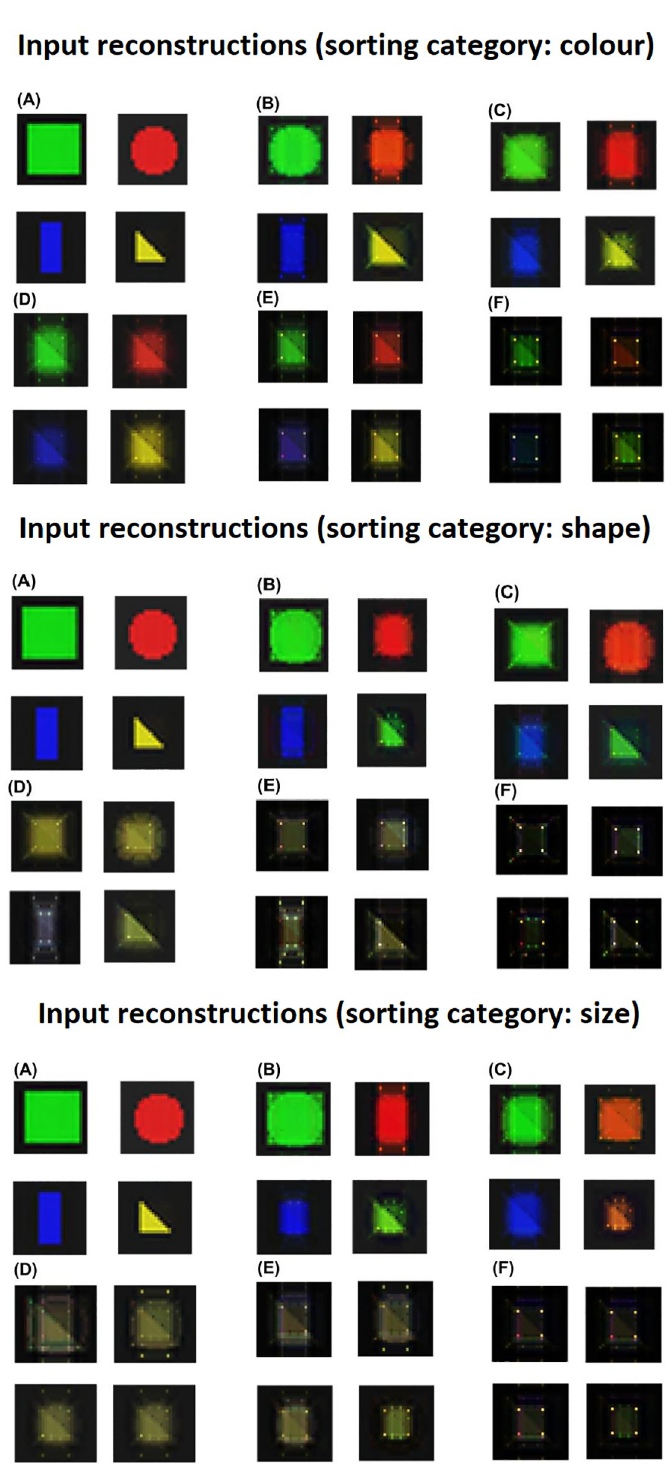
Fig 11. Input reconstructions (sorting category: Colour) Input reconstructions (sorting category: Shape) Input reconstructions (sorting category: Size). Image reconstructions with different sorting rules and different levels of